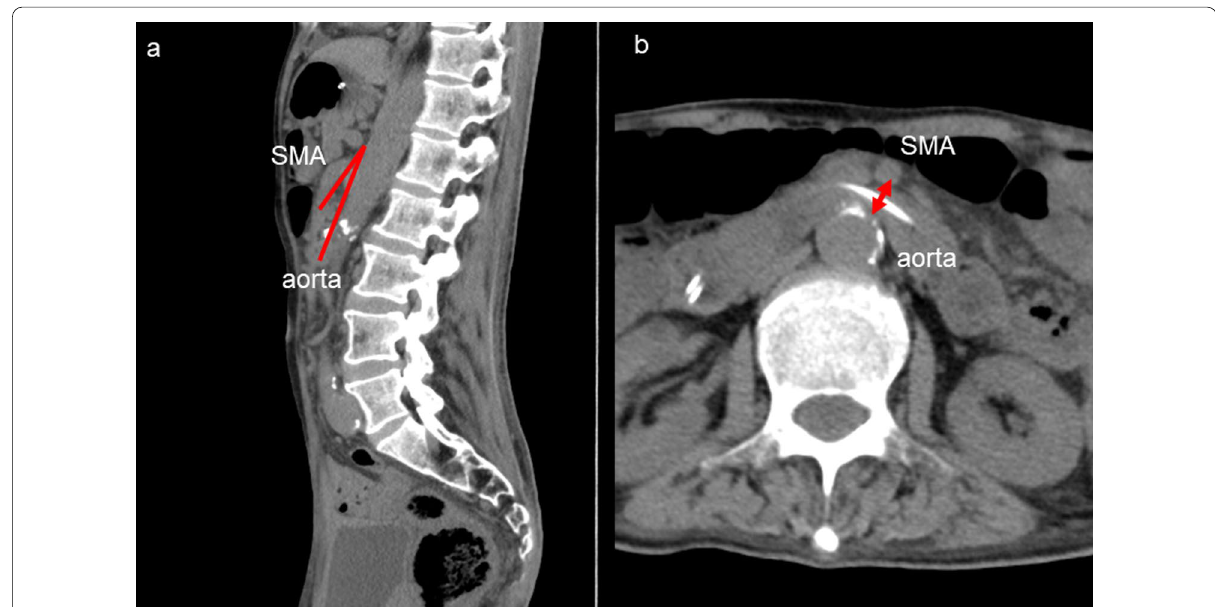
Fig. 2 Computed tomography findings. a Sagittal view. b Axial view. The aorto-mesenteric angle is narrow at 18° and the aorto-mesenteric distance short at 8